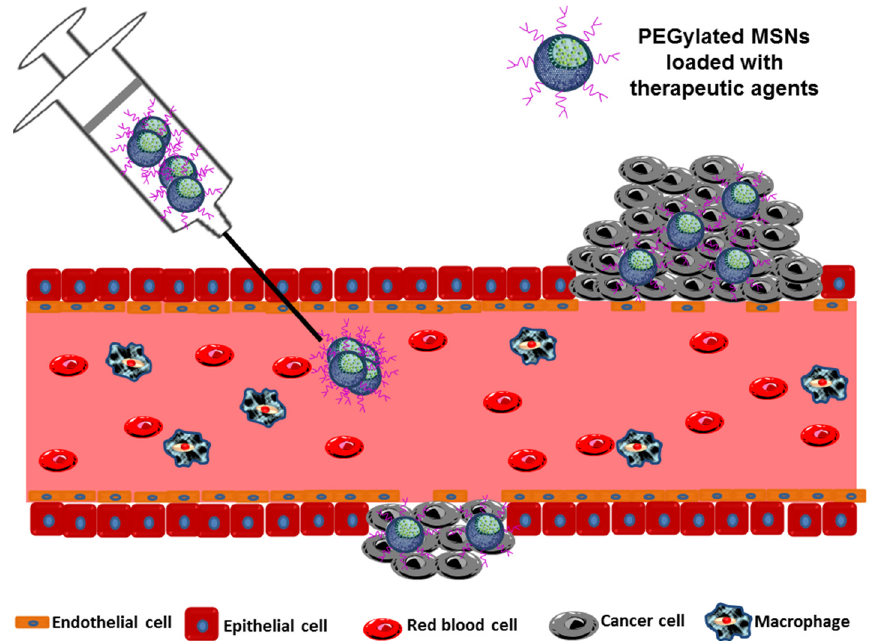
Figure 3. Schematic illustration of enhanced permeation and retention (EPR)